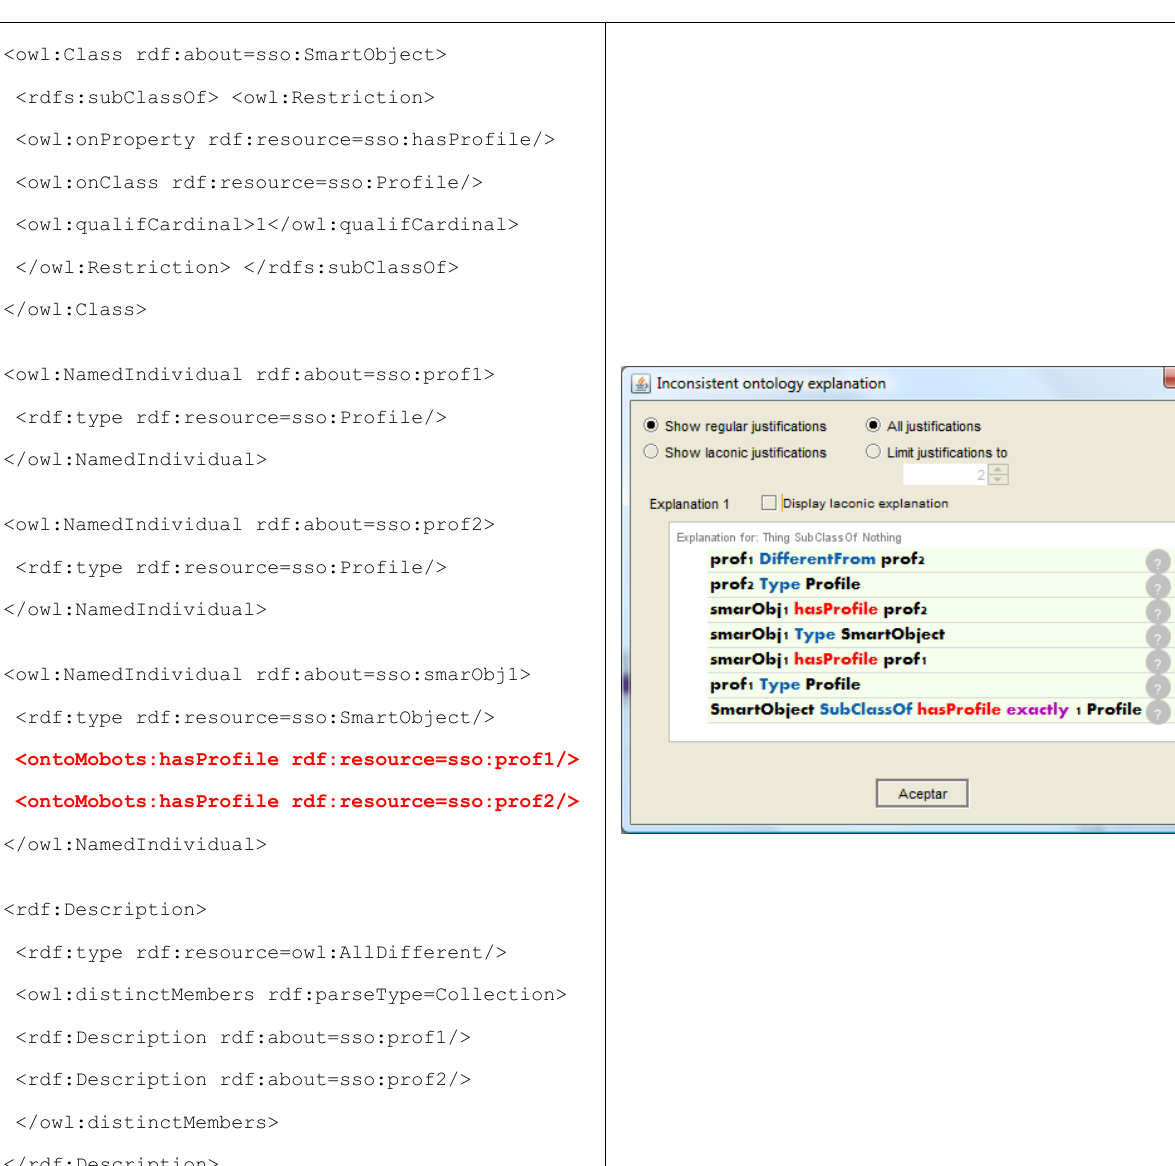
Figure 8. Example of inconsistent deployment scenario KB (consistency